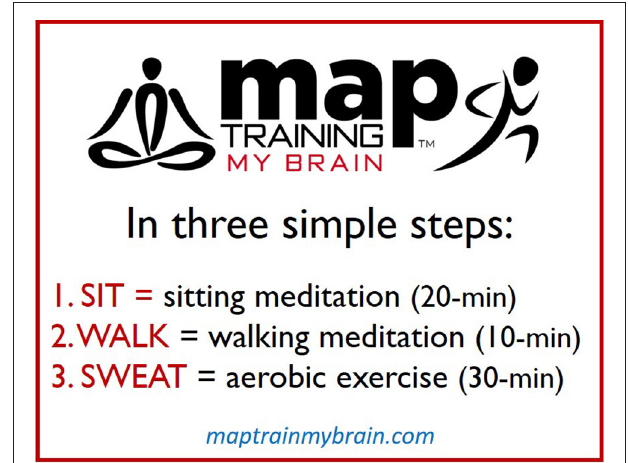
FIGURE 1 | Each session of Mental and Physical (MAP) Training consists of 20-min of sitting meditation, followed by 10-min of very slow walking meditation, ending with 30-min of aerobic exercise with heart rate maintained at 60–80% of the participant’s maximum.